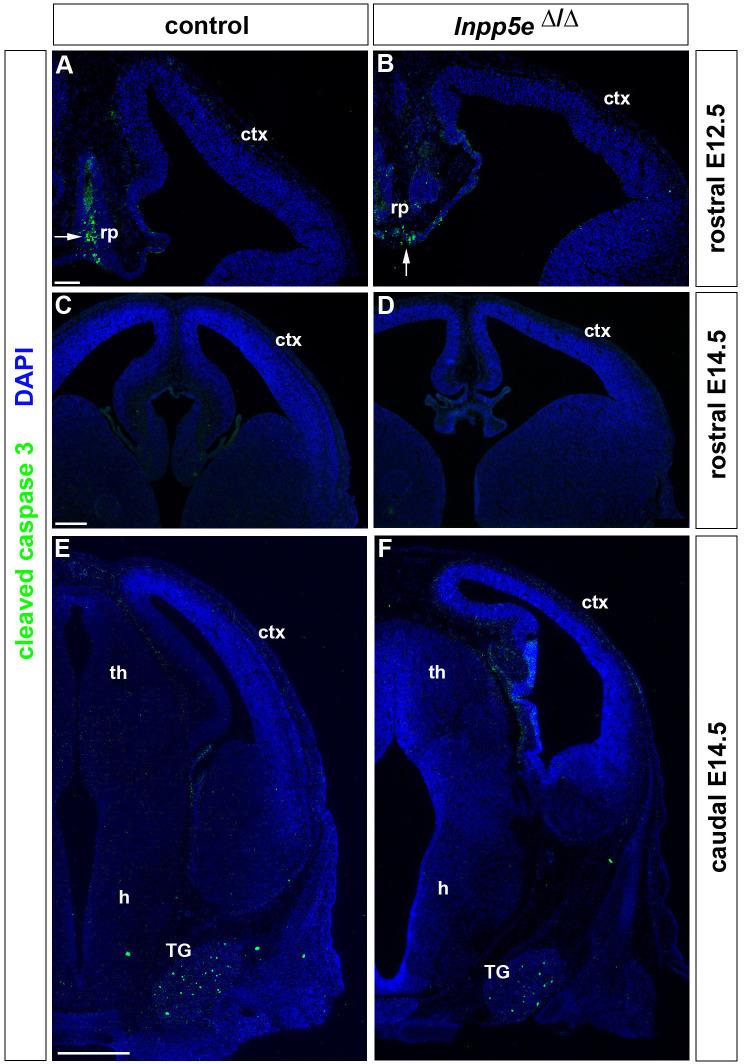
Apoptosis in the developing forebrain of Inpp5eΔ/Δ embryos.(A–F) Immunofluorescence staining for Cleaved Caspase three revealing apoptic cells. (A, B) Programmed cell death was detected in the midline roof plate (rp) but hardly in the developing neocortex of E12.5 control (A) and Inpp5eΔ/Δ embryos (B). (C–F) In E14.5 embryos, very few apoptotic cells were identified in the neocortex while apoptosis is widespread in the trigeminal ganglion (TG) (E, F). ctx: cortex. Scale bars: (A): 100 μm, (C): 25`0 μm, (D) 500 μm.